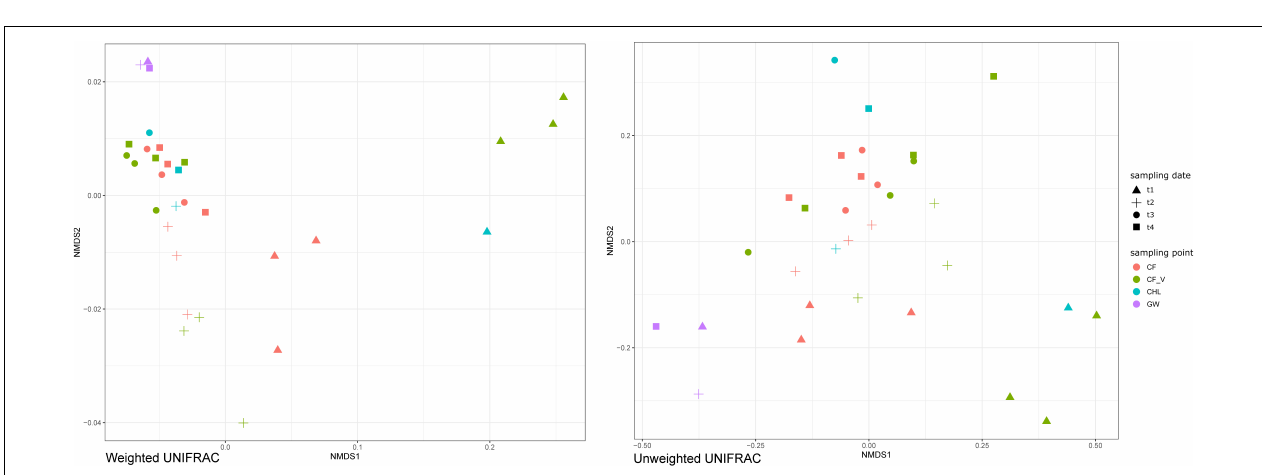
FIGURE 5 | Barchart visualization depicting the relative abundance and distribution of the most abundant ASVs assigned to the Family taxonomic rank. GW: groundwater samples; CF_V: samples collected after the passage through granular activated vegetal carbon filters; CF: samples collected after the passage through granular activated vegetal carbon filters; BULK: downstream bulk GACs samples; t1–t4: sampling dates.